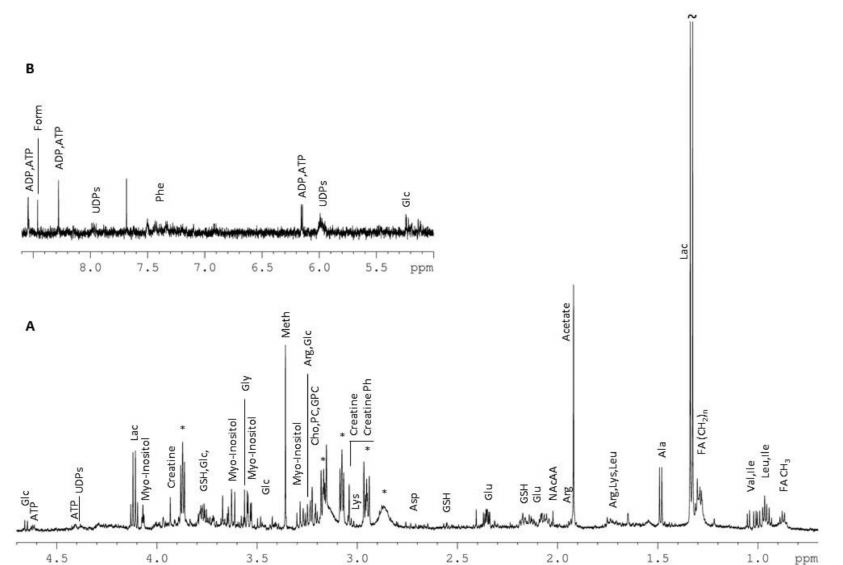
Figure 6. 1 H 1D NMR (One-dimensional Nuclear Magnetic Resonance) spectrum of the aqueous extracts of MG-63 cells treated with ADR (Adriamycin) and OLEU (Oleuropein) ( A ): 4.70–0.70 ppm and ( B ): 8.60–5.00 ppm). The spectrum intensity in panel B is four times maximized, compared to panel A. Asterisks point to HEPES (4-(2-hydroxyethyl)-1-piperazineethanesulfonic acid) resonance peaks. "~" used for peaks whose intensity is not fully displayed. * p < 0.05 compared to control cells. ADP: